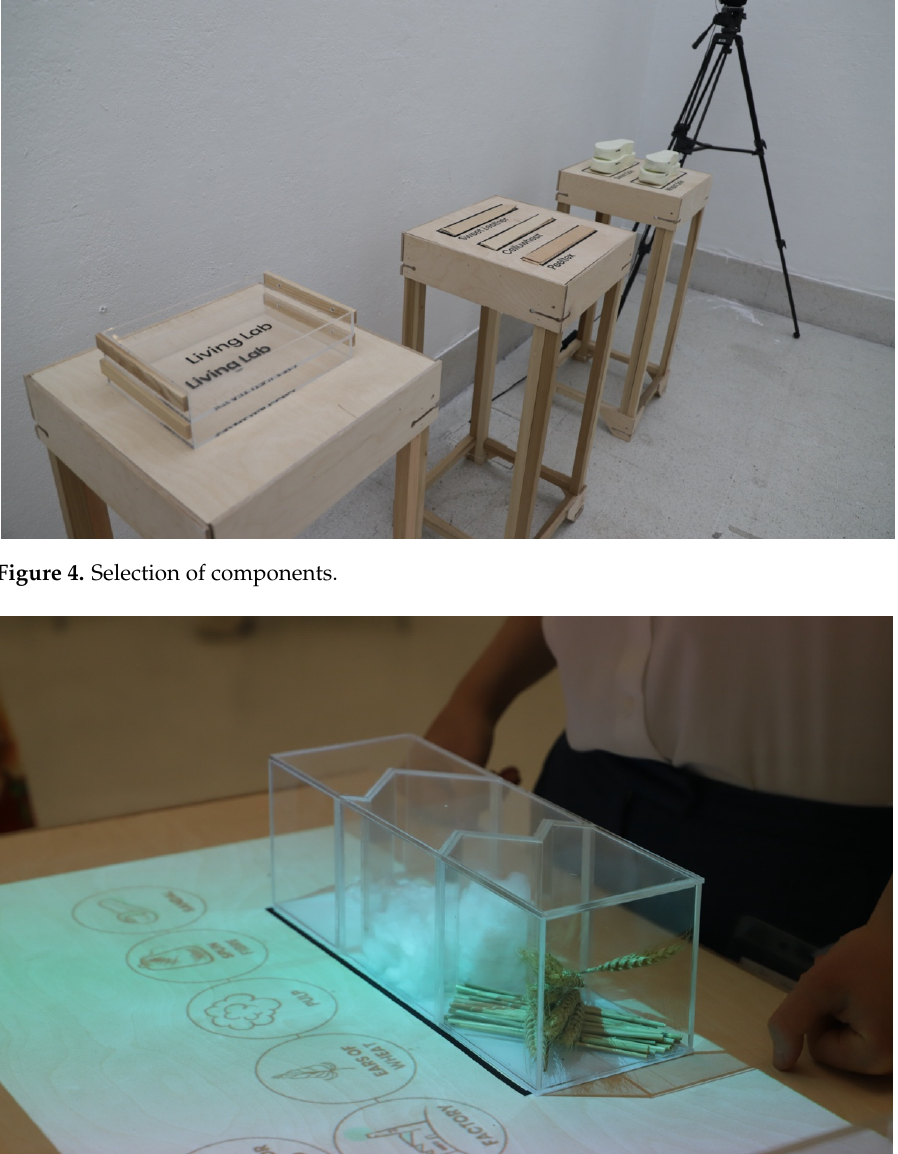
Figure 6. Material Futures.